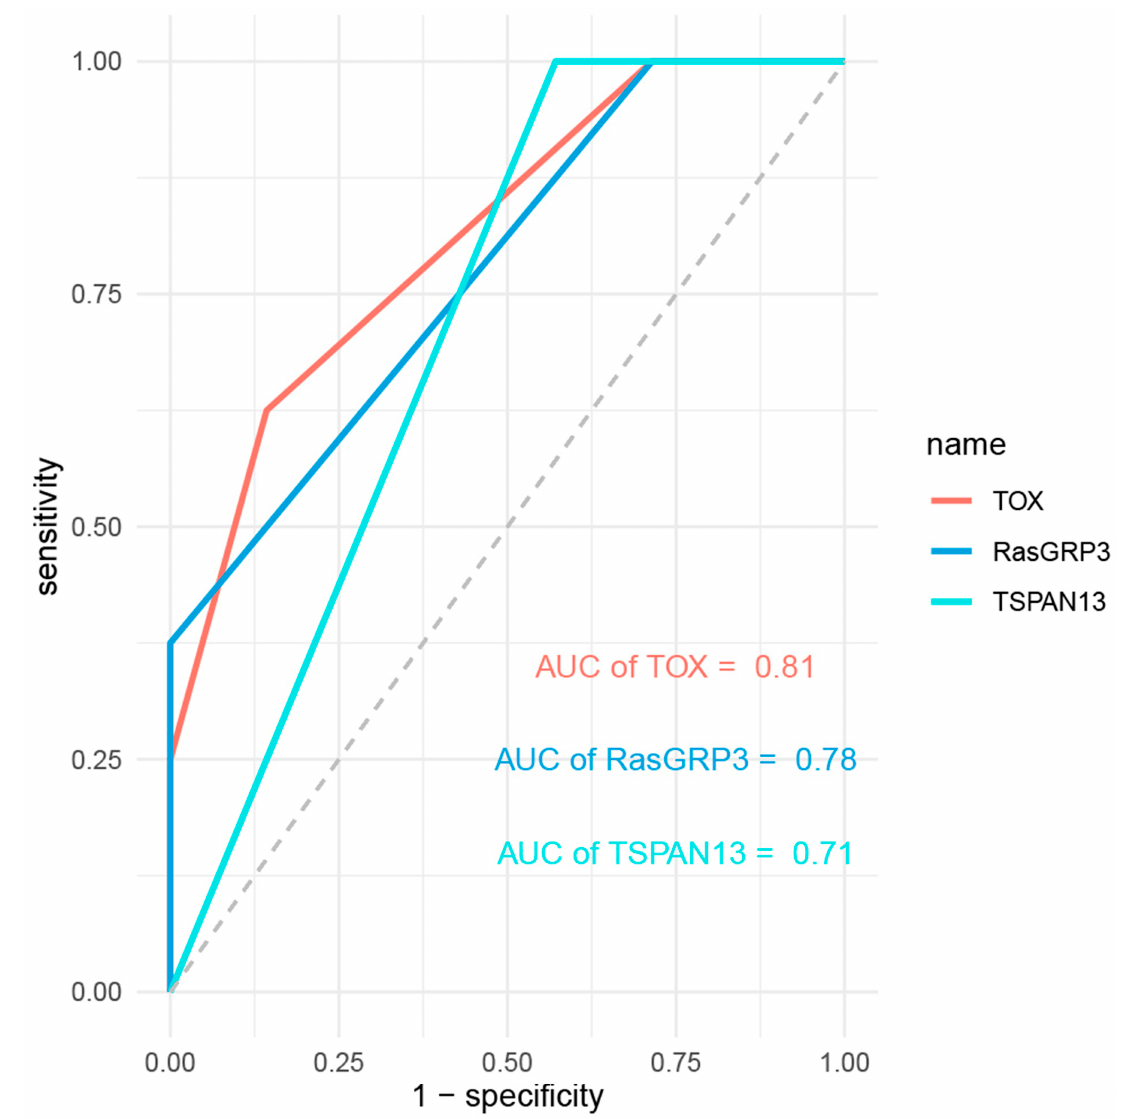
Figure 5. ROC figure of TOX, RasGRP3, and TSPAN13. The AUC of TOX, RasGRP3, and TSPAN13 was 0.81, 0.78, and 0.71, respectively.